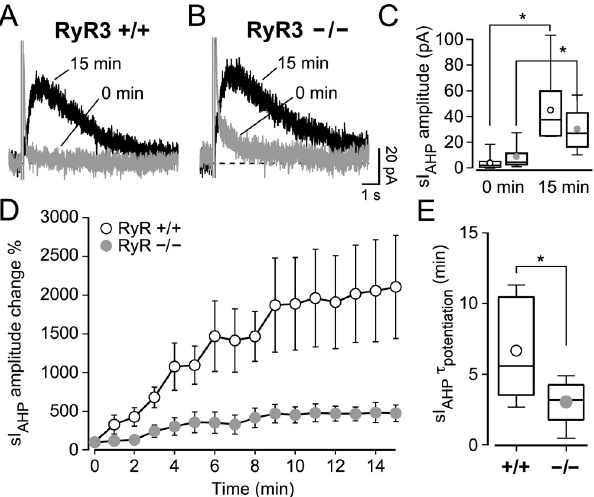
Fig 6. CA1 pyramidal neurons lacking type 3 ryanodine receptor (RyR3 − / − ) have a faster and reduced activity- dependent potentiation of sI AHP . ( A, B) Superimposed traces of the sI AHP recorded at 0 and 15 minutes from RyR3 +/+ and RyR3 − / − CA1 pyramidal neurons. ( C) Box-and-whiskers plot summarizing the sI AHP amplitudes recorded before the run-up phase (0 min) and at the end of potentiation (15 min). At 0 min the sI AHP peak amplitude in RyR3 +/+ (mean ± SEM: 4.2 ± 1.8 pA; median = 2.3 pA; n = 10) and in RyR3 − / − CA1 pyramidal neurons (mean ± SEM: 9.2 ± 3.4 pA; median = 4.7 pA; n = 7) was similar (P = 0.07, Mann-Whitney test). At steady state (15 min) the amplitude of sI AHP was similar in RyR3 +/+ neurons (mean ± SEM: 45.2 ± 8.1 pA; median = 37.7 pA; n = 10) and in RyR3 − / − (mean ± SEM: 30.5 ± 6.1 pA; median = 27.1 pA; n = 7) (P = 0.2). This shows that a clear potentiation was observed for both RyR3 +/+ (P = 0.0006, paired t-test) and RyR3 − / − (P = 0.006, paired t-test) neurons, because the sI AHP amplitude at steady state was clearly larger when compared with sI AHP amplitude at the beginning of the recording. ( D) Time course of relative amplitude increase of sI AHP during the first 15 min of the recording, with current amplitudes normalised to the starting current measured at 0 min. The sI AHP potentiation was overall larger in RyR3 +/+ than in RyR3 − / − CA1 pyramidal cells (two-way ANOVA with Bonferroni’s test, P < 0.001). ( E) The time constant ( τ ) of sI AHP potentiation was obtained by fitting a mono-exponential function to the sI AHP amplitude during the run-up phase of each individual experiment. The time constant of potentiation was faster in RyR3 − / − (mean ± SEM: 3.1 ± 0.7 min; median = 3.2 min; n = 7) compared to RyR3 +/+ CA1 neurons (mean ± SEM: 6.7 ± 1.1 min; median = 5.6 min; n = 10) (P =